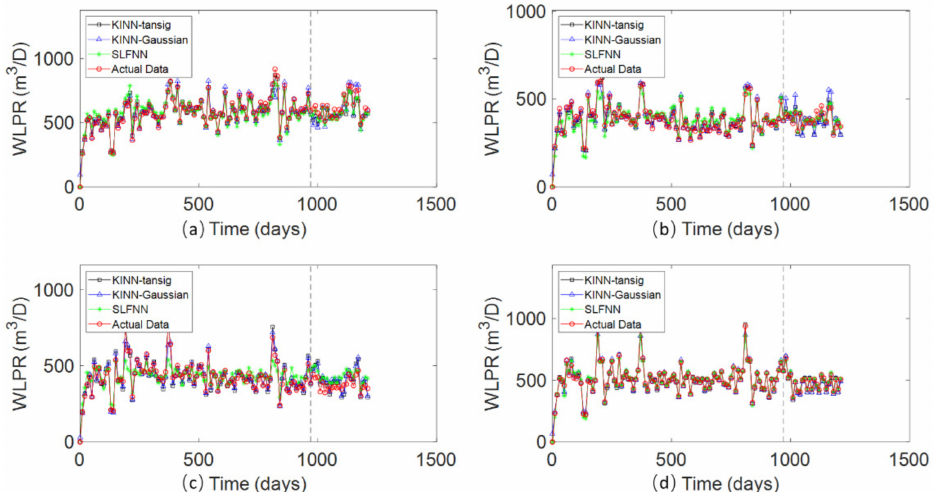
Figure 14. History matching results of the Egg reservoir case by KINN-tansig, KINN-Gaussian and SLFNN. The black line with squares is the result obtained by KINN-tansig method; the blue line with triangles represents the result gotten by KINN-Gaussian method; the green line with stars is the results obtained by SLFNN; the red line with circles is the liquid production rate gotten by ECLIPSE; the grey vertical dashed line makes a separation of history matching period and the productivity forecast period: ( a ) P1; ( b ) P2; ( c ) P3; ( d ) P4.